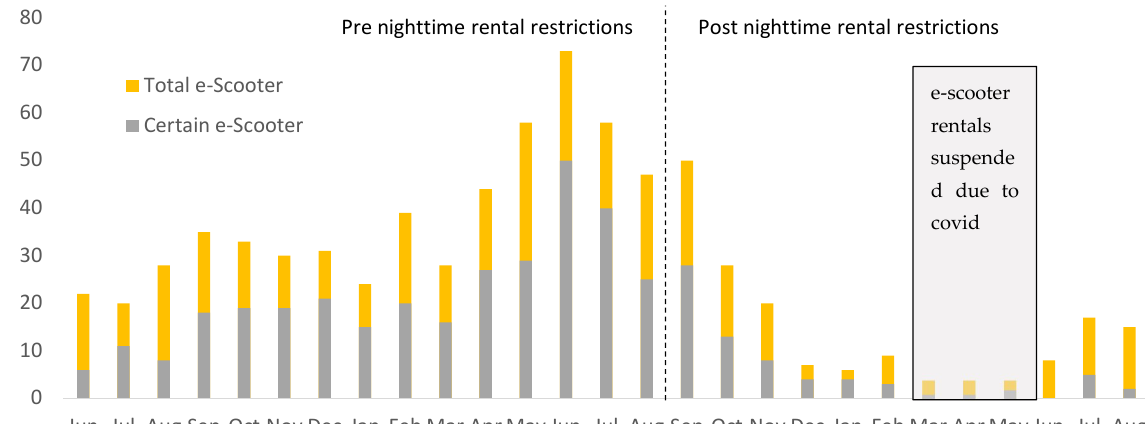
Figure 2. Total and certain e-scooter injuries by month.